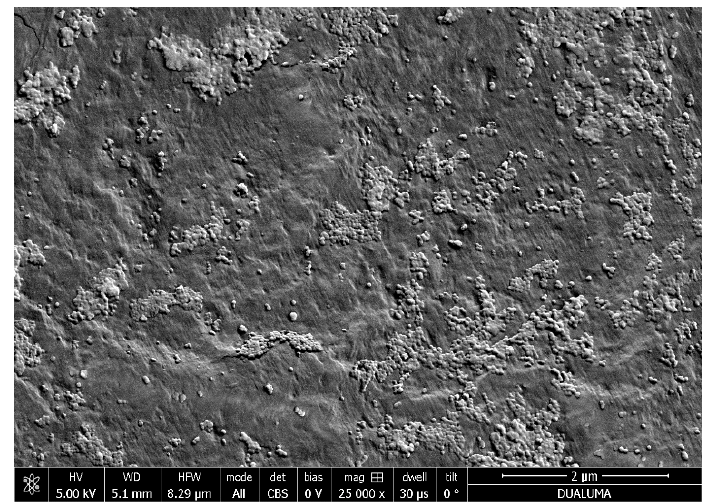
Figure 4. FE-SEM images of RC-4/CdSe-QDs@S-DAB 5 film.